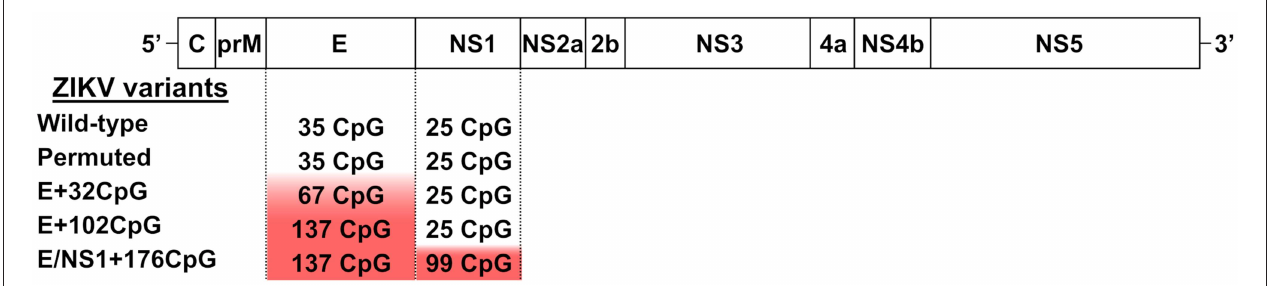
FIGURE 1 | The genome of ZIKV and the recoding strategy. ZIKV genomic regions encoding E and NS1 proteins were recoded to increase the number of CpG dinucleotides. The actual number of CpG dinucleotides in the ZIKV genomic regions is denoted.